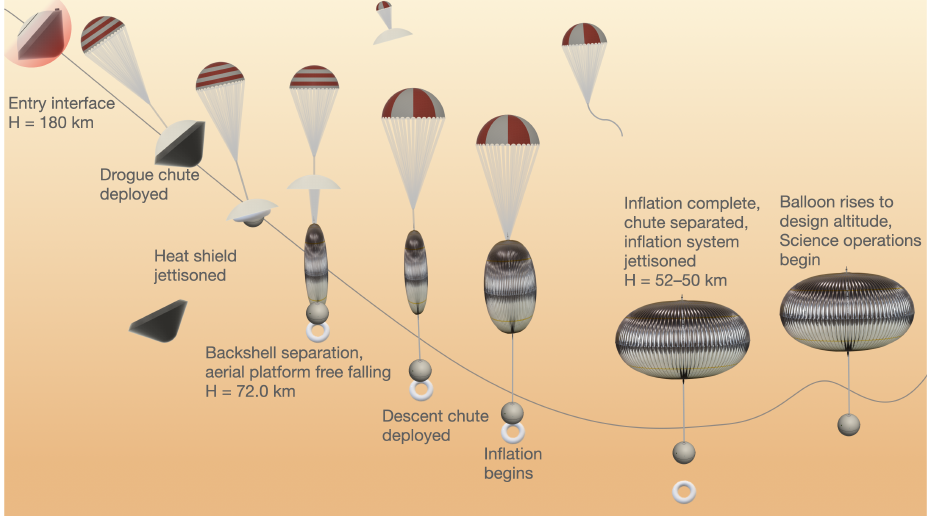
Figure 10. Representative concept of operations for a